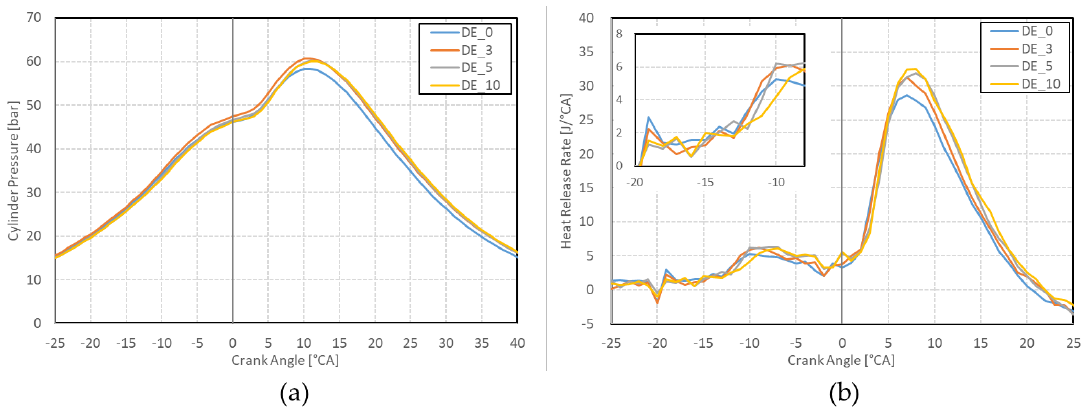
Figure 3. ( a ) Combustion pressure and ( b ) heat release rate of test fuels.